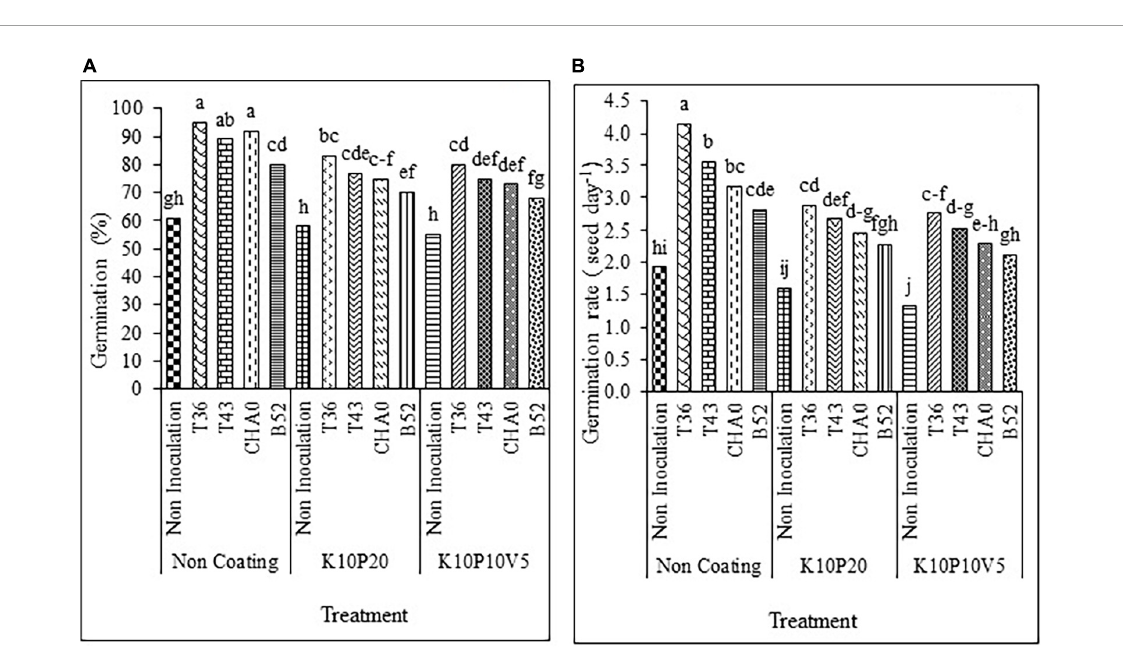
FIGURE2 Interaction of (A) germination percentage and (B) germination rate (seed d - 1 ) of anise affected by inoculation + coating treatments. Means with the same letter are not significantly different according to the HSD test at P = 0.05. CHA0, B52 of Pseudomonas fluorescens , T36 and T43 of Trichoderma harzianum isolates. K, kaolin; V, vermiculite; P,